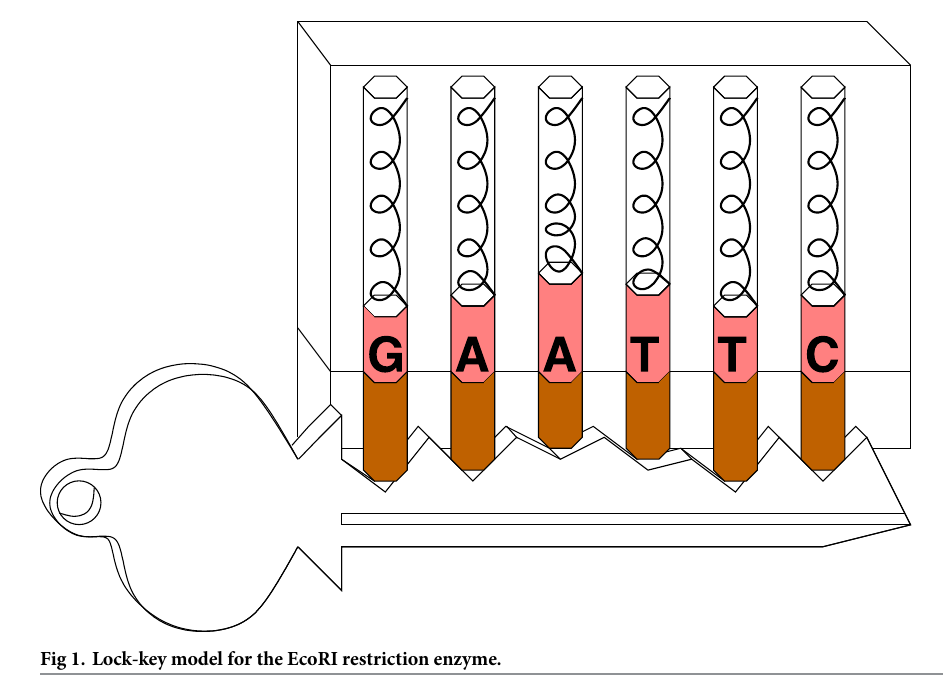
Fig 1. Lock-key model for the EcoRI restriction